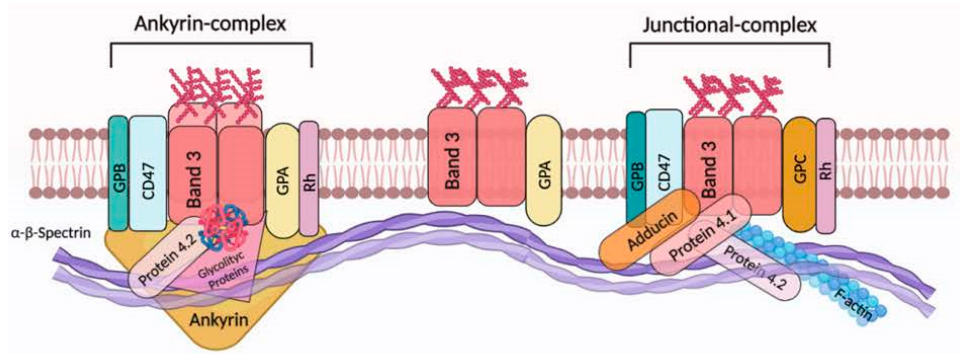
Figure 1. Band 3 interactions in the human RBC membrane. In RBCs, band 3 presents as an oligomeric form (dimers and/or tetramers) or alternatively as larger aggregates [35]. Dimeric band 3 protein complex is composed of freely moving band 3 dimers with glycophorin A (GPA). However, band 3 molecules (as dimers) are thought to be associated with junctional complexes. In particular, this multiprotein complex is represented by band 3 dimers, adducin, protein 4.1, glycophorin C (GPC) and Rh. Meanwhile, the band 3 tetrameric complex (the ankyrin complex) is organized as a tetramer of band 3 bound to protein 4.2 and ankyrin, alongside GPA. Ankyrin/protein 4.1 and/or protein 4.2/actin binding to band 3 facilitates the association with the underlying α - β -spectrin cytoskeleton [30]. Sedimentation and extractability experiments indicate that both glycolytic proteins and deoxyhemoglobin are associated with the tetrameric form of band 3. Recently, it was demonstrated that Rh protein, CD47, and glycophorin B (GPB) are associated with band 3 (tetrameric form) [35]. This figure was created using BioRender.com.